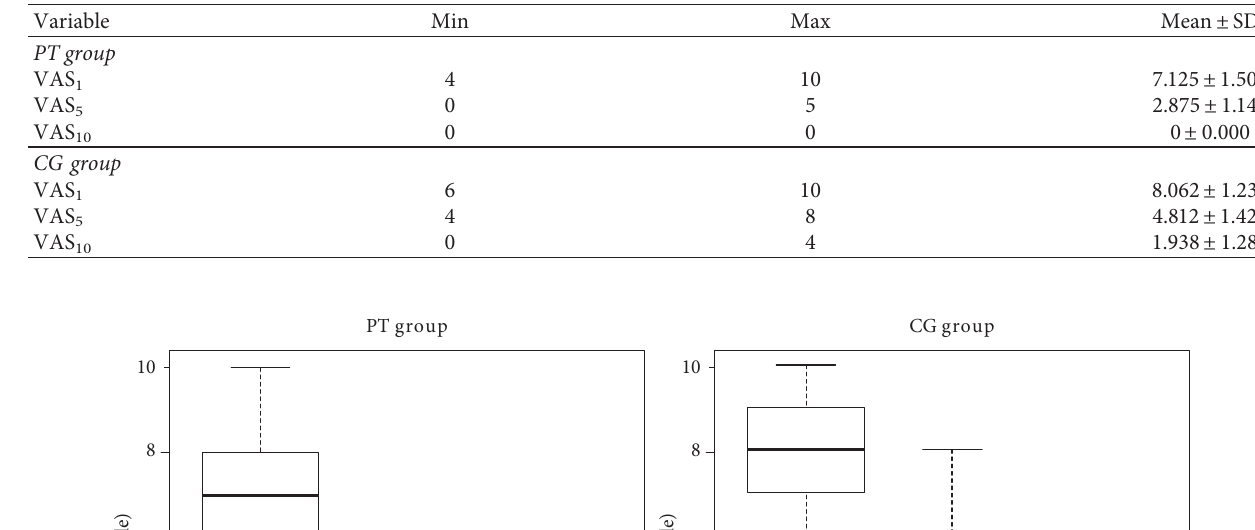
Table 1: Descriptive statistics for pain